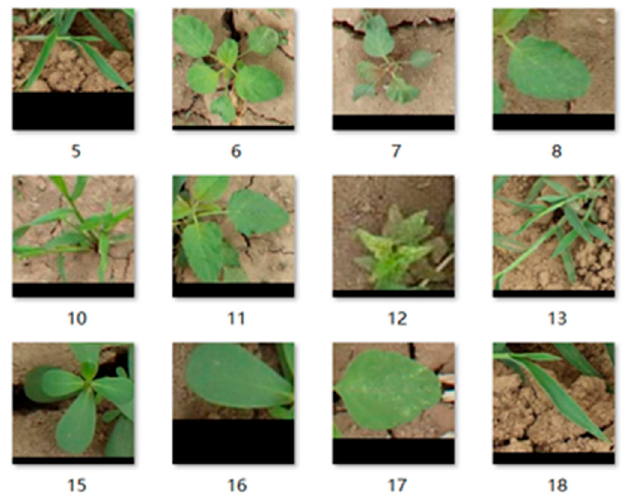
Figure 4. Positive sample dataset.